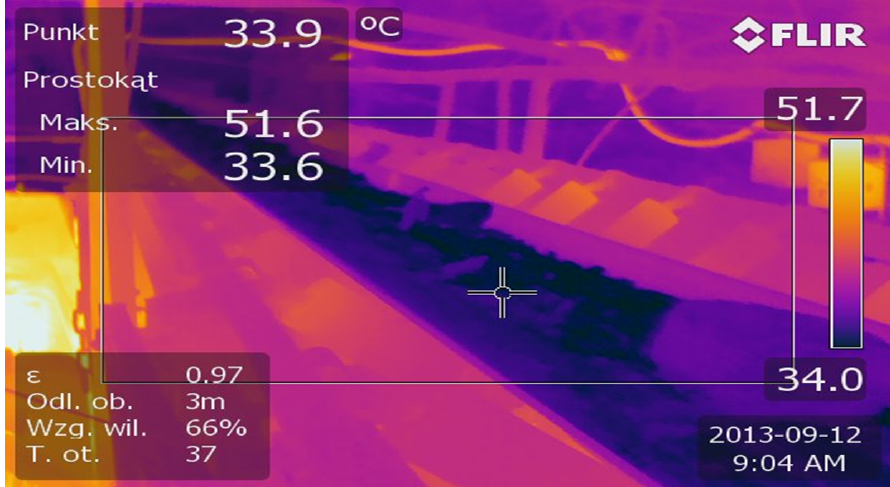
Figure 26. Belt Conveyor as IR